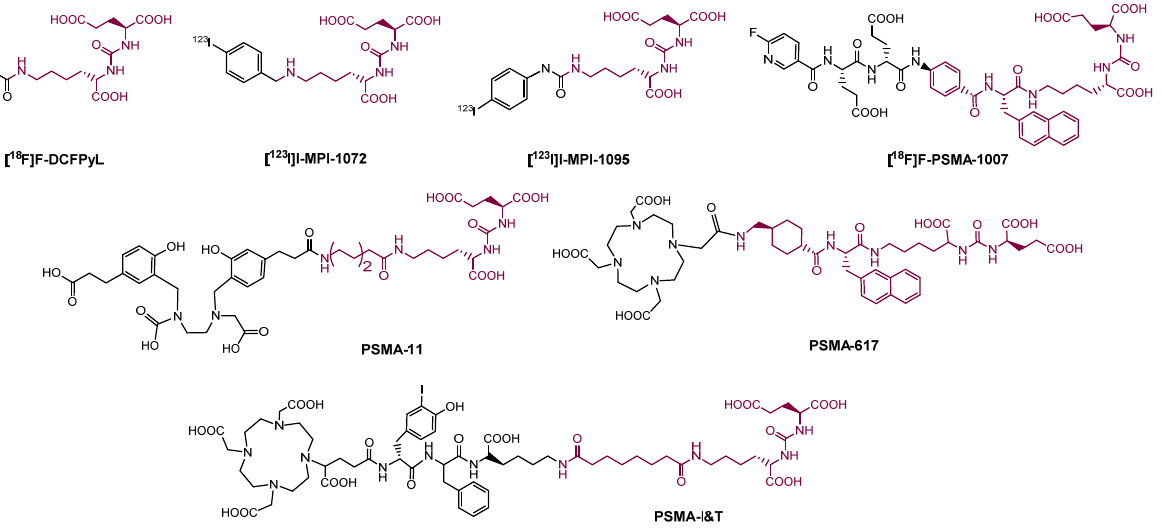
Figure 3. Chemical representation of selected labeled and unlabeled PSMA-i derivatives. PSMA-i pharmacophore is evidenced in color. pharmacophore is evidenced in